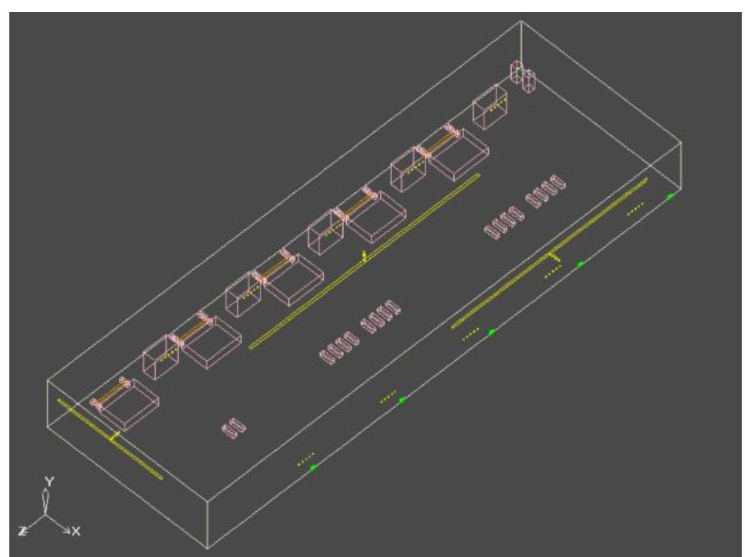
Figure 6. Working Condition 5 layout of natural